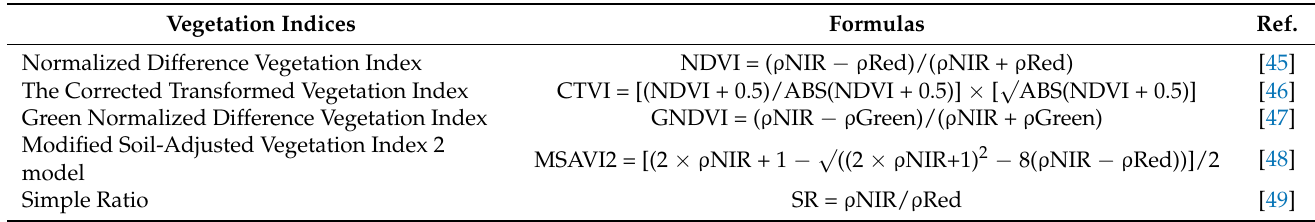
Figure 2. An overview of images analysis process in the 2018 sorghum field trial under well-watered and drought stress conditions. ( A ) RGB (Red Green Blue) orthomosaic showing field design with plots segmentation at the 76th days after sowing; ( B ) DSM (Digital Surface Model) map. ww: well-watered; ds: drought stress. Table 2. Vegetation indices used in this